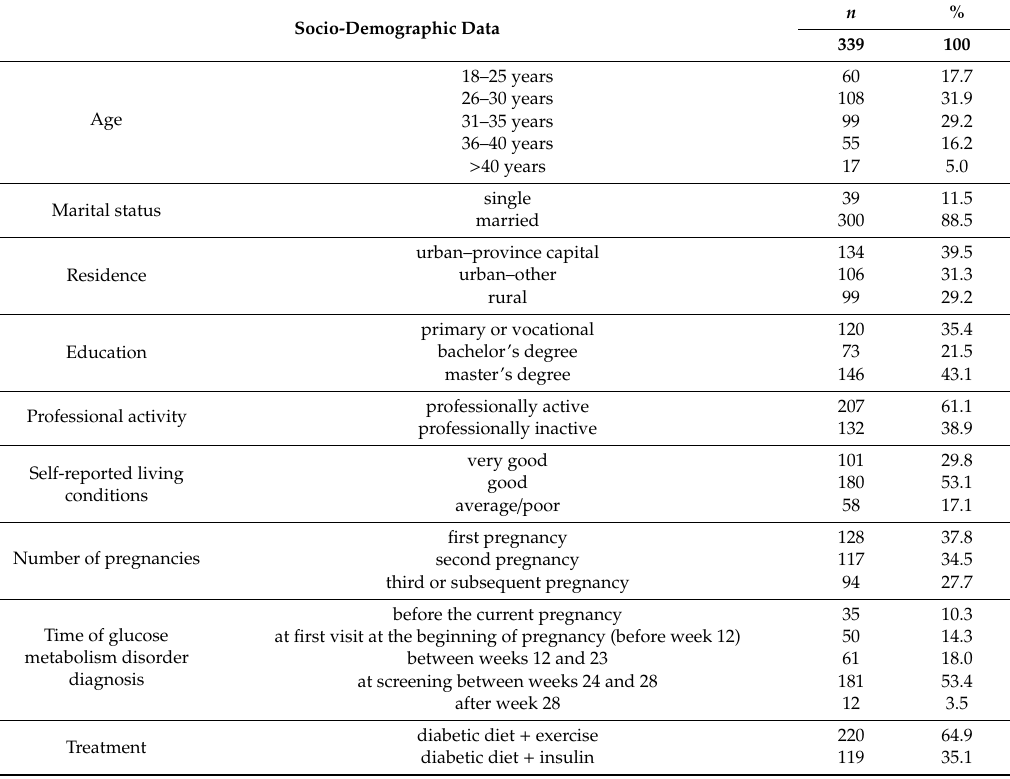
Table 1. Socio-demographic characteristics of the hyperglycemic pregnant women studied. Socio-Demographic Data